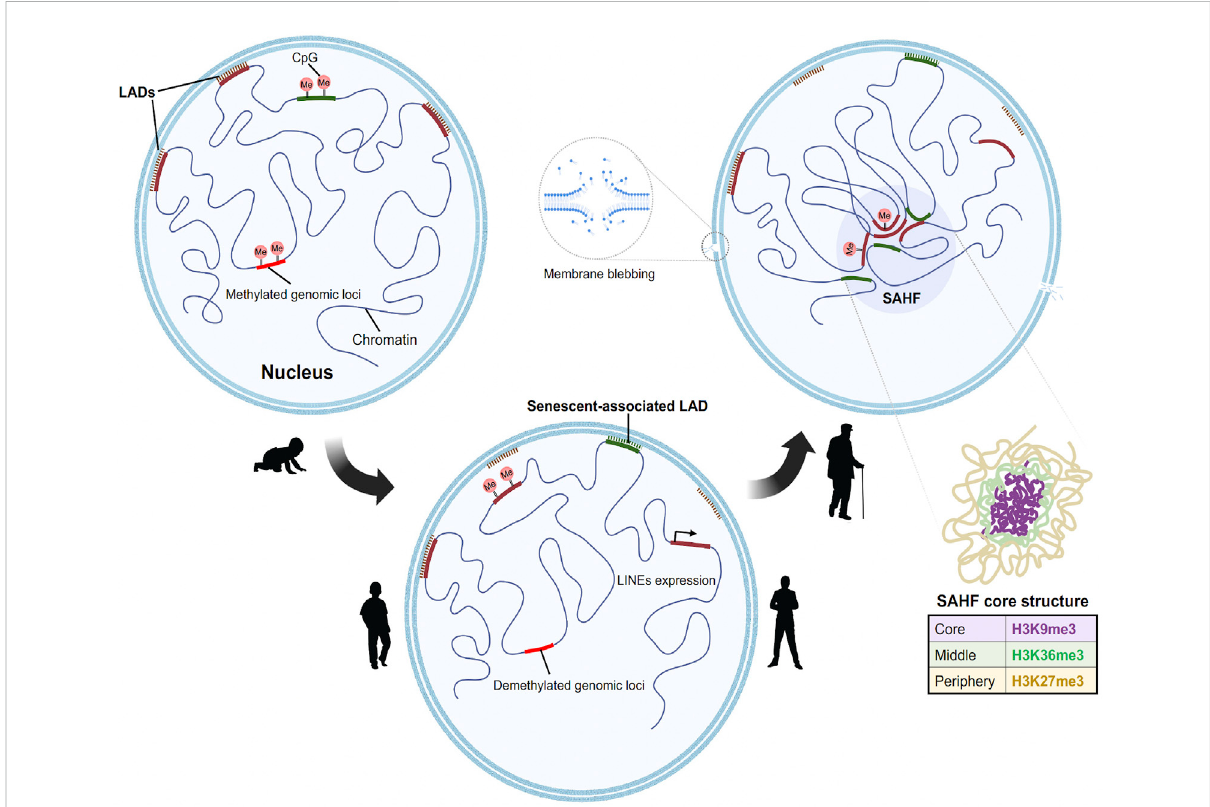
FIGURE 2 Model forstep wiseformation ofsenescenceHeterochromatin fociinagednuclei. Inayoung proliferating cell (from left) , theLaminassociated domains (LADs) (markedin red), consistof compactedH3K9me3containing constitutive heterochromatinwhichare tethered to the nuclear lamina. This constitutive heterochromatin is often fl anked by H3K27me3 regions. At the onset of senescence (center), the LADs detach fi rst from the lamina which results in the decondensation of the heterochromatin. This process is followed by the spatial clustering of constitutive heterochromatin to form senescent associated heterochromatin foci. Novel regions in the genome gain Lamin B1, moves towards the periphery to form senescent associated LADs. In addition to this there is global DNA methylation changes. Hypomethylation at the LINEs and SINEs activates the elements and leads toaberrant transcription.The genomefurther undergoes subsequent redistribution toform thesenescentfoci.The corestructureoftheSAHF consists of differential chromatin as depicted in layers